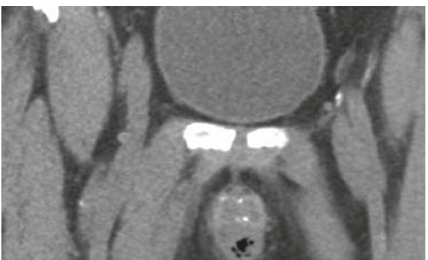
Figure 1: Coronal view of pelvic CT image demonstrating em- physematous changes in the bulb of the corpus spongiosum.